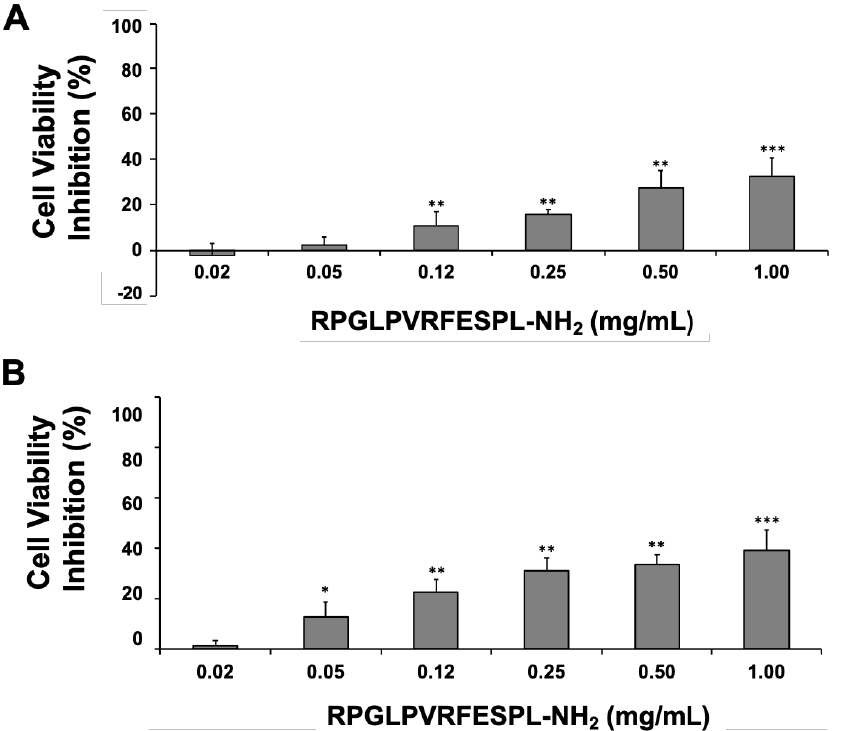
Figure 6. Action of the RPGLPVRFESPL-NH 2 peptide on L929 cell viability after 24 and 48 h. L929 cells were pre-incubated for 24 h, increasing concentrations of the synthetic peptide were added to the 96-well plates, and cells were analyzed after incubation for ( A ) 24 h and ( B ) 48 h. Each bar represents the mean ± standard deviations of three repetitions. (* p <0.05, ** p <0.005, *** p <0.0001; One way-ANOVA, follow Tukey ’ s Multiple Comparison Test).